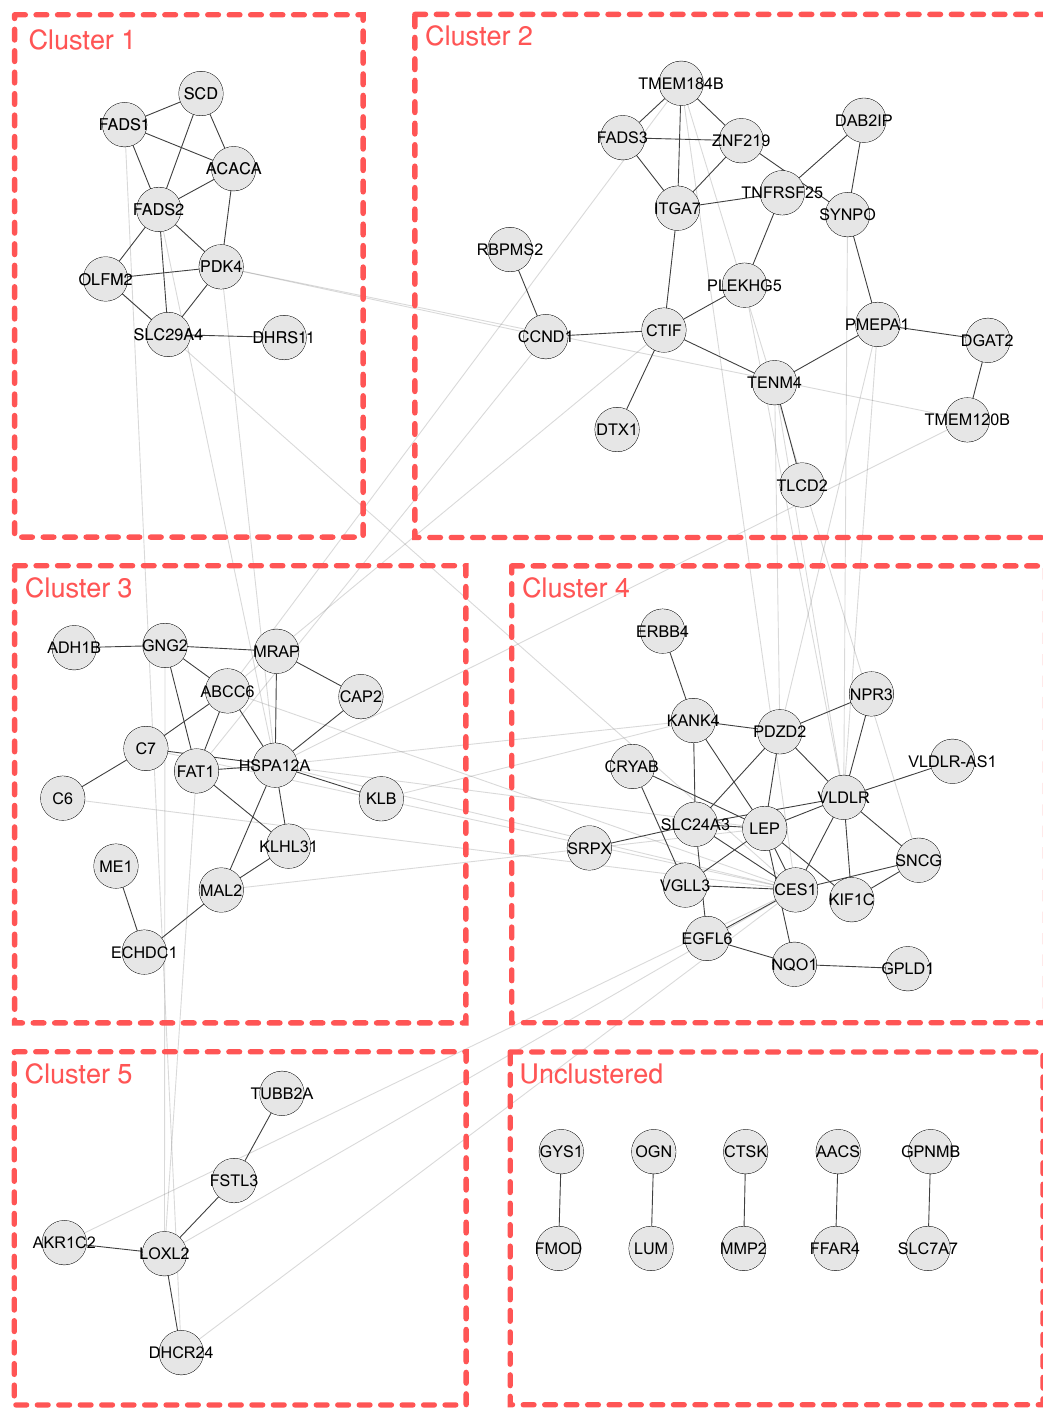
Figure 4. GLay community clusters of the overlap network. Faded edges show the edges removed by the algorithm to generate the “community” of genes based on the